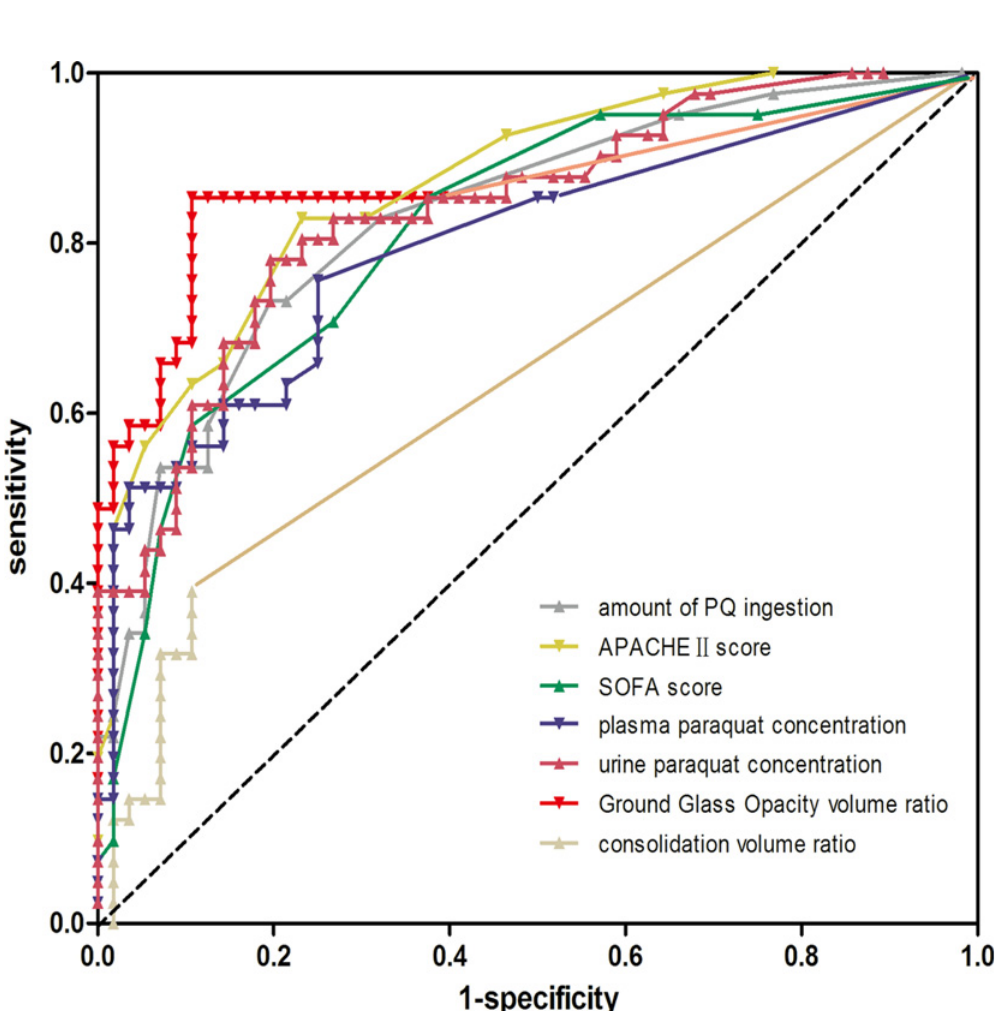
Fig 3. Kaplan-Meier survival curves of 97 paraquat poisoned cases stratified according to different CT findings within the first 5-day period. Patients were categorized into two groups based on whether or not they presented the specific CT finding. The P values were derived by log-rank